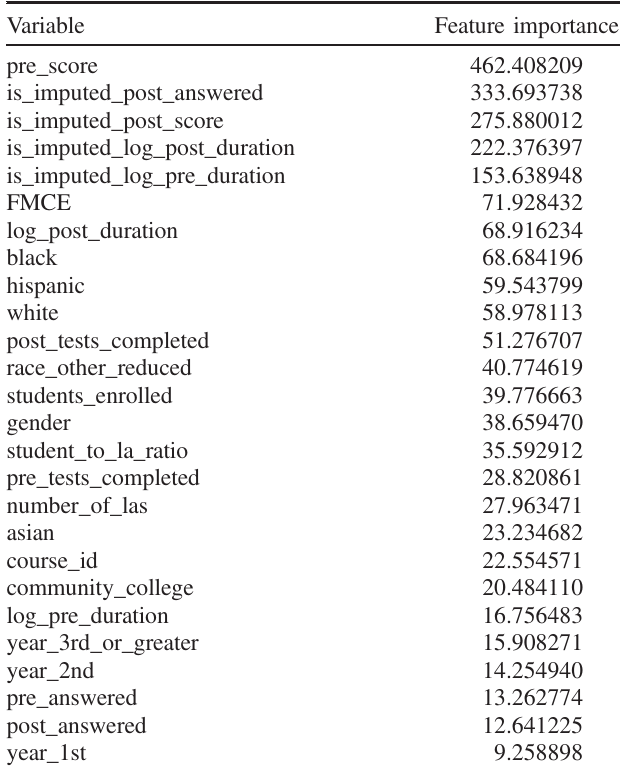
TABLE VII. Feature importances for gradient boosted model. The feature importance in this table represents the gain [52].